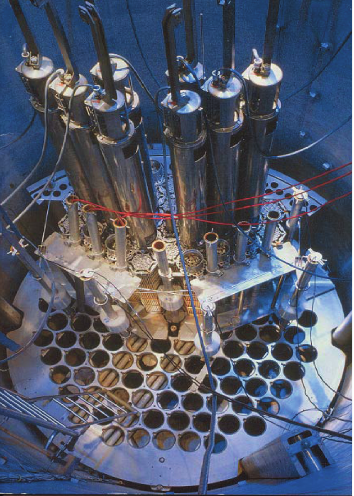
Figure 3: The section of the mockup by the XY plane.